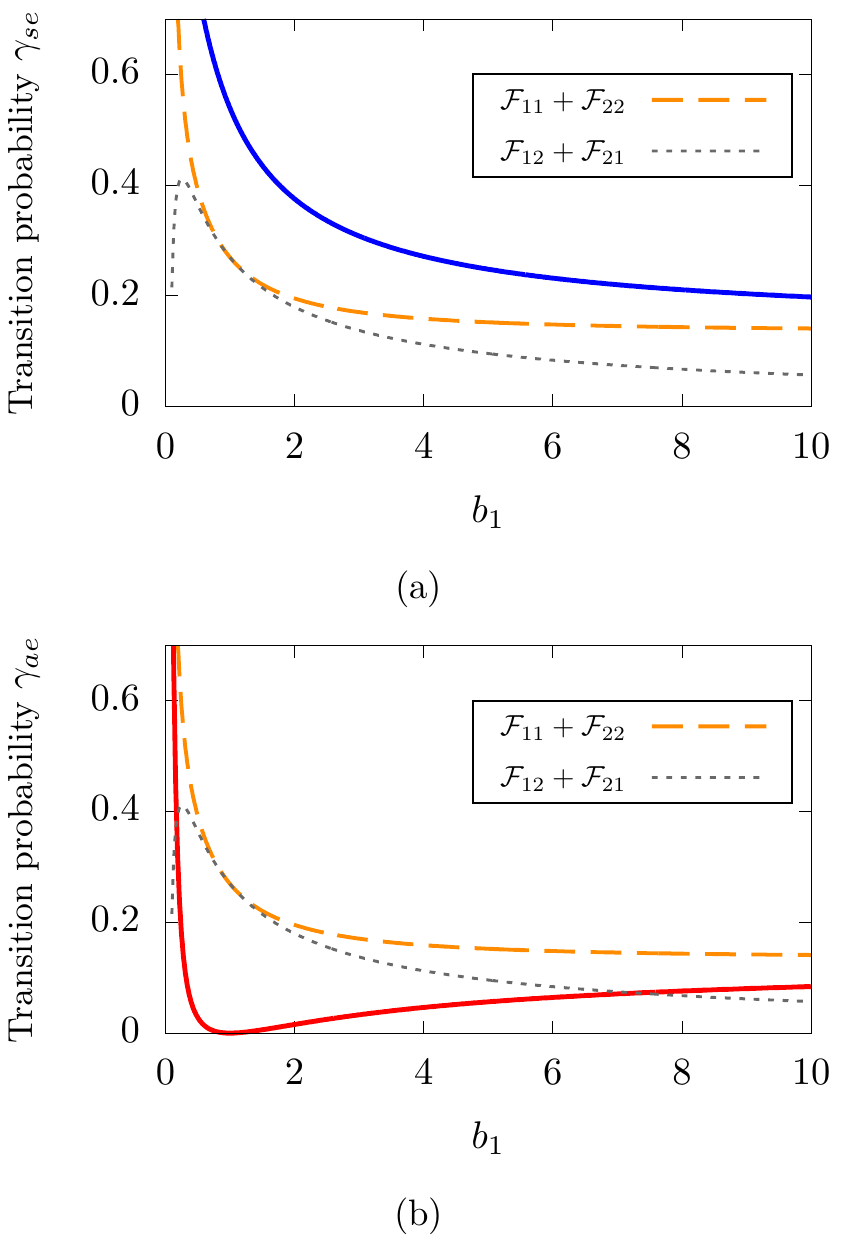
Figure 3 . (1 + 3) dimensions: (a) The transition probability from the symmetric state to the collective excited state denoted by the solid blue line. (b) The transition probability from the anti-symmetric state to the collective excited state denoted by the solid red line. In both of the cases b 2 = 1 is kept fixed and b 1 is varied. The orange dashed and gray dotted lines denote the contributions from ( F 11 + F 22 ) and ( F 12 + F 21 ) respectively. We have considered the values of the other parameters to be ∆ E = 0 . 1 , ω k = 0 . 1 and β = 2 π